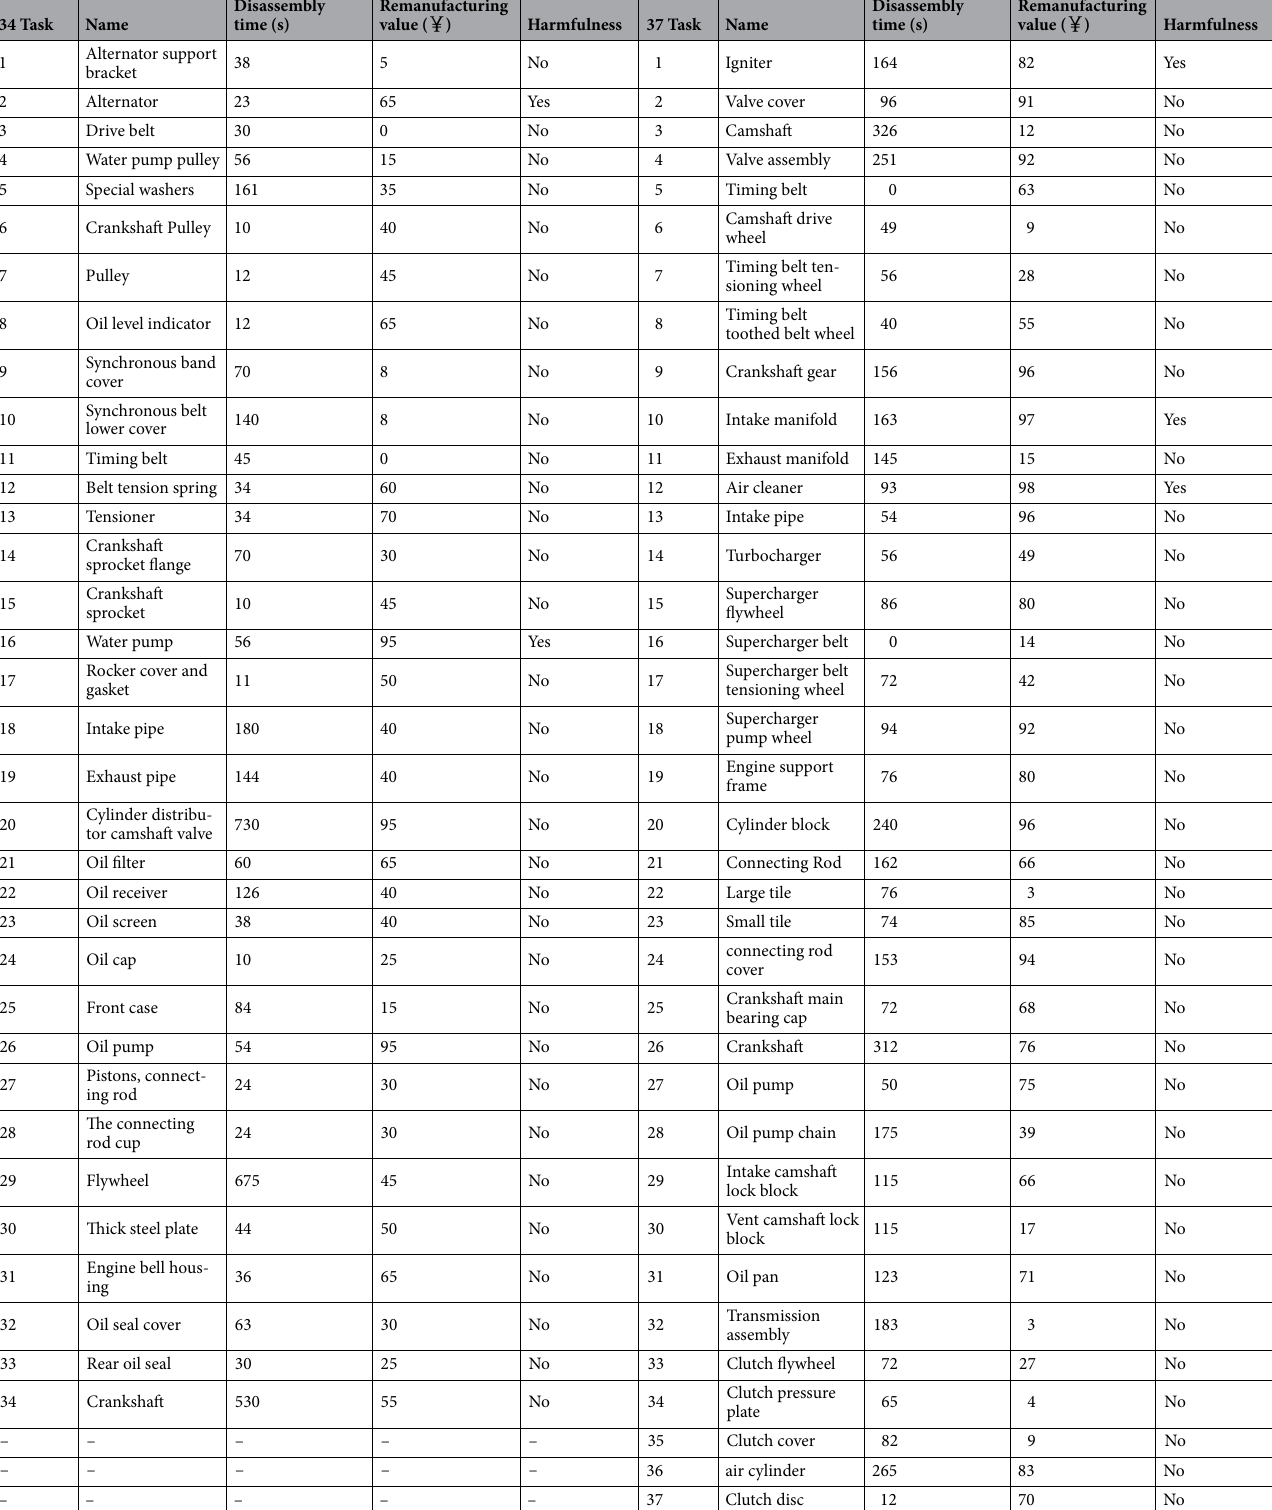
Table 3. Component information for the two engine